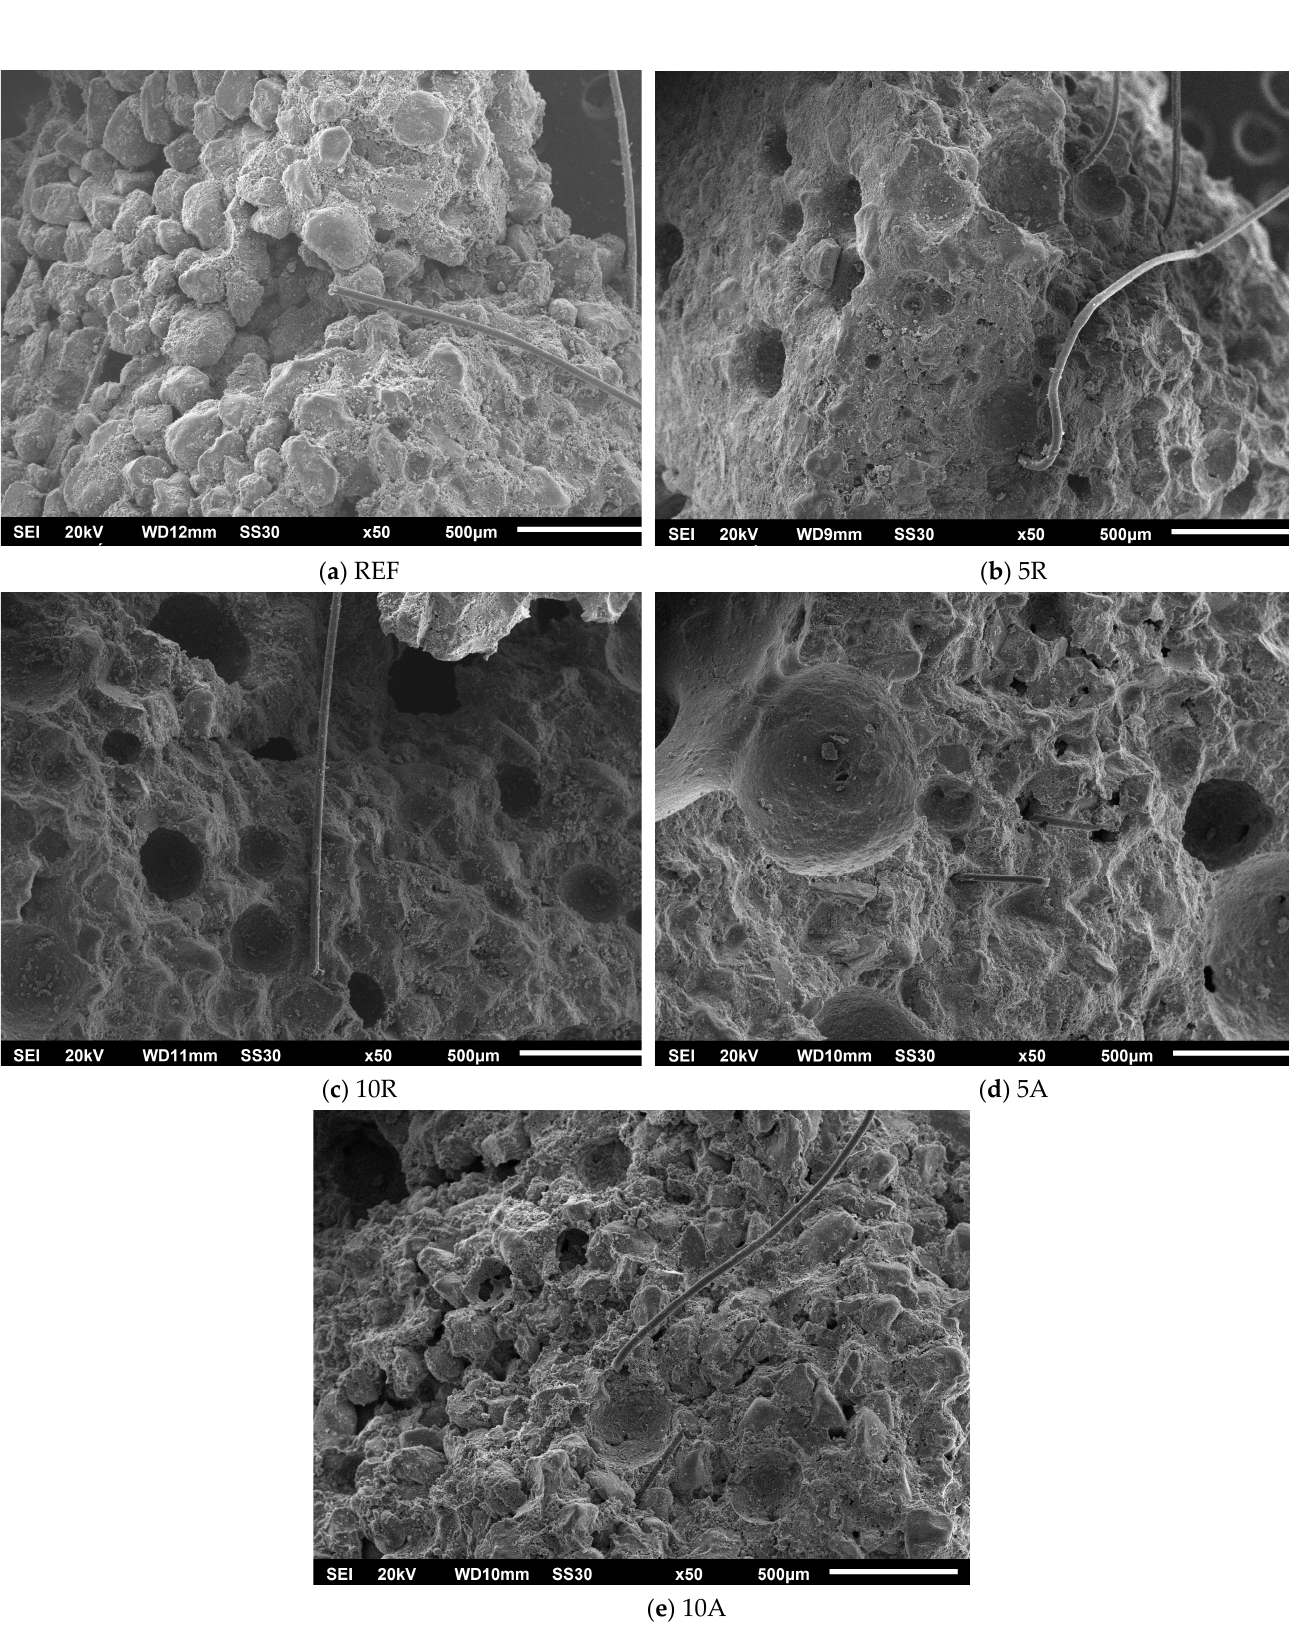
Figure 7. Scanning electron microscopy (SEM) images, with 50x magnification: ( a ) REF, ( b ) 5R, ( c ) 10R, ( d ) 5A, ( e ) 10A.